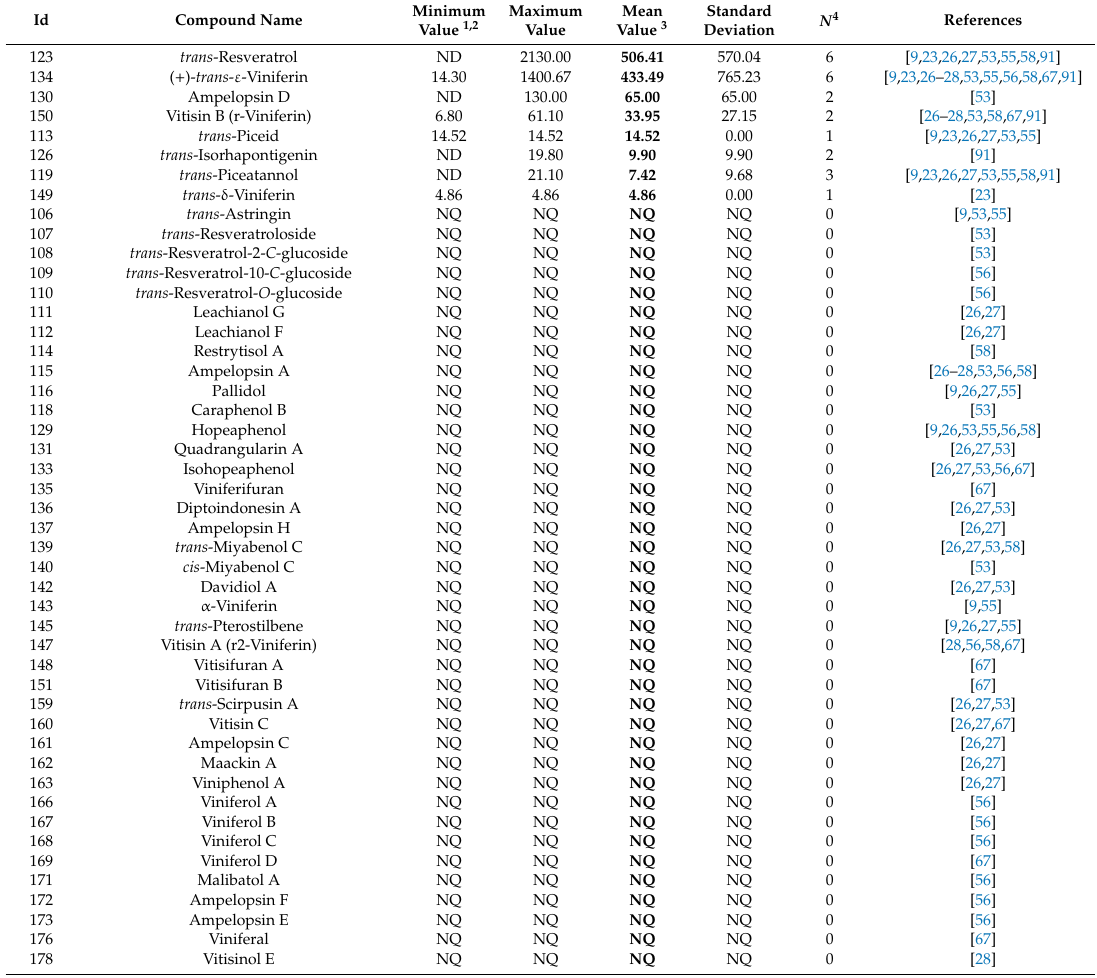
Table 6. Levels (mg / kg) of 47 stilbenic compounds identified in grapevine